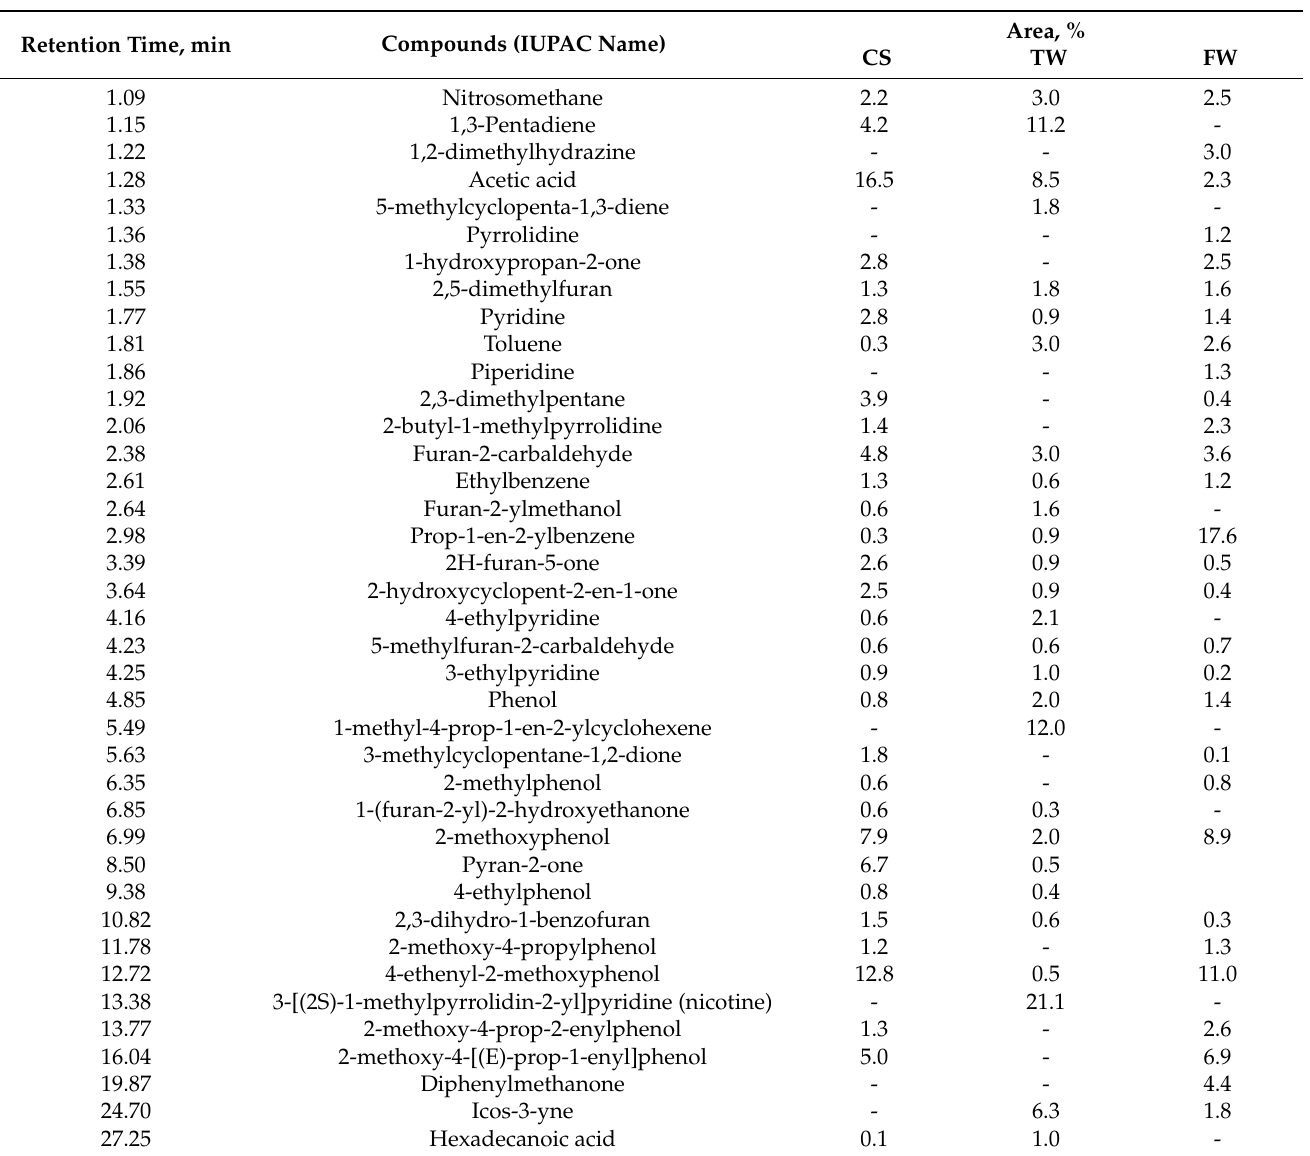
Table 3. Chemical compound distribution determined by Py-GC-MS analysis (area%) of waste biomass feedstocks (CS, TW, and